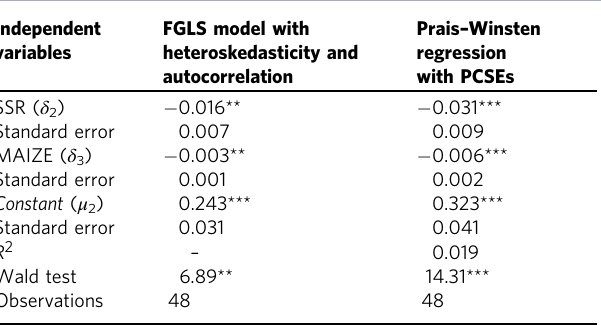
Table 12 Estimation results of model 2 in panel data analysis.